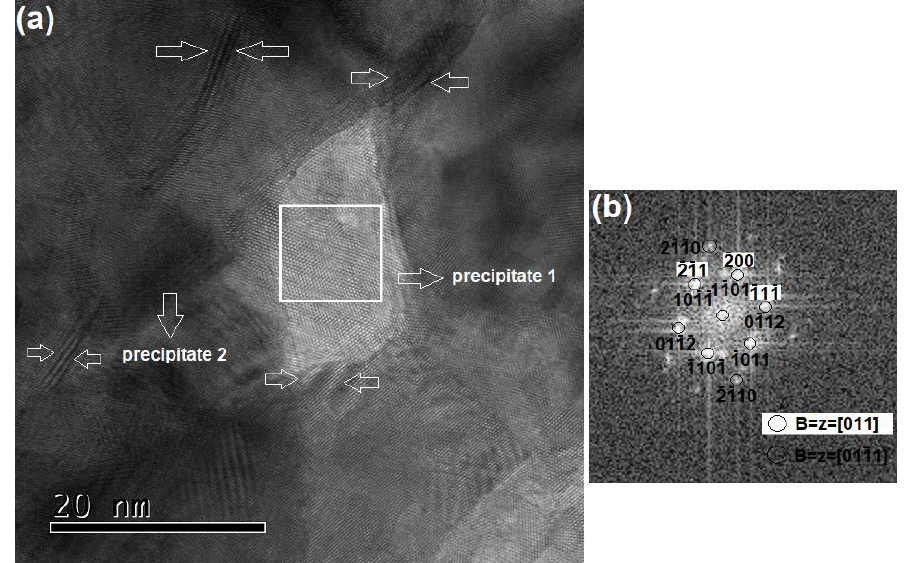
Figure 7. HRTEM micrograph of the extruded Zn-12.5Ag-1Mg alloy: ( a ) bright-field image showing an Ag 0.15 MgZn 1.85 precipitated in an AgZn matrix and ( b ) the corresponding FTT.